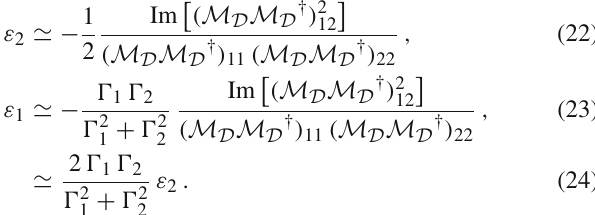
out of equilibrium condition of N 1 . All the points in both plots satisfy the neutrino oscillation data in the 3 σ